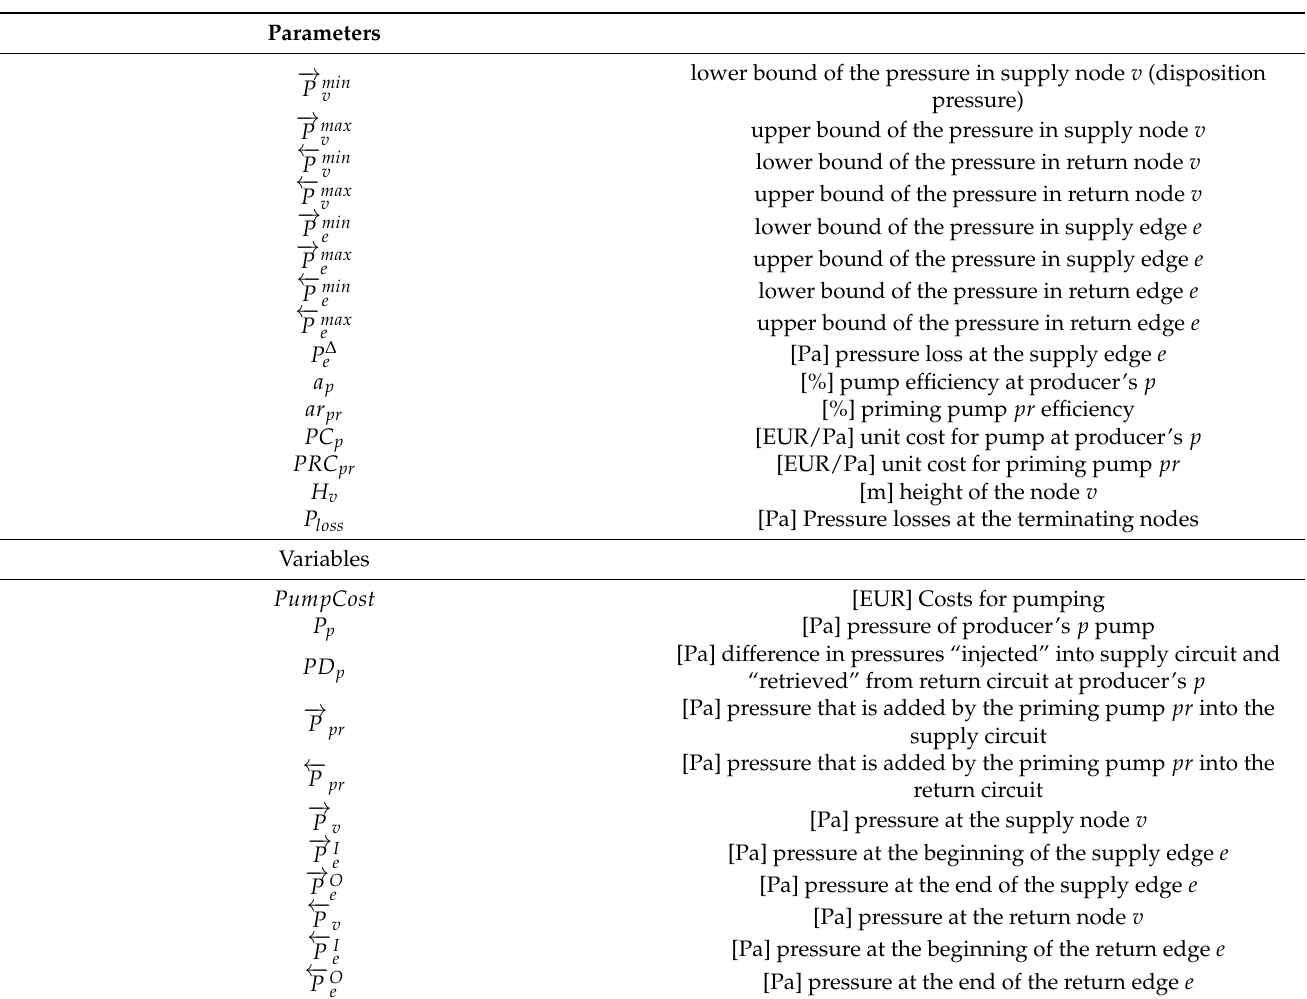
Table A4. List of parameters and variables used in the pressure model